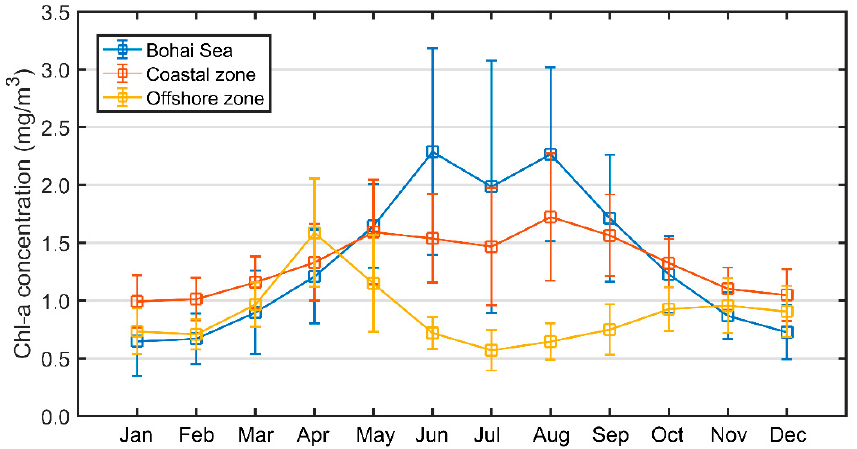
Figure 3. Average monthly chl-a concentration in the Bohai Sea, the Yellow Sea Coast, and the Yellow Sea offshore zones.